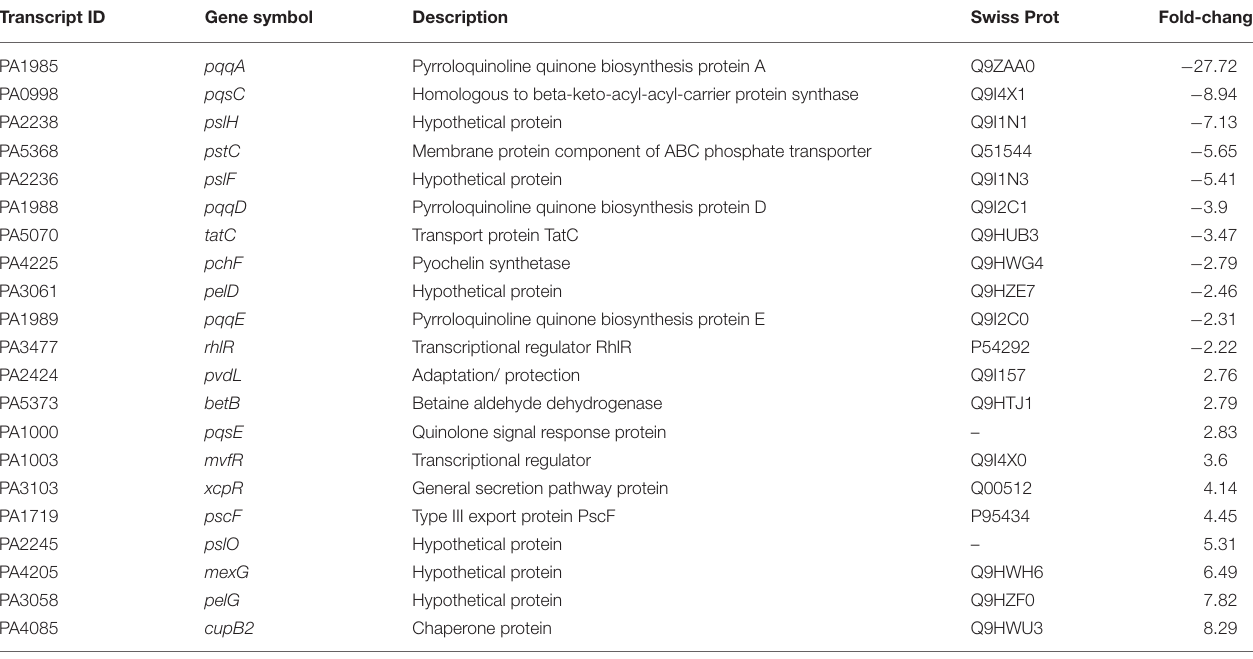
TABLE 2 | Selected transcripts that differentially expressed (up- or down- regulated) in P. aeruginosa PAO1, treated with bacterial ( D. tsuruhatensis SJ01) active fraction (C18-100; containing 1,2-benzenedicarboxylic acid, diisooctyl ester) compared with control (untreated PAO1 strain).